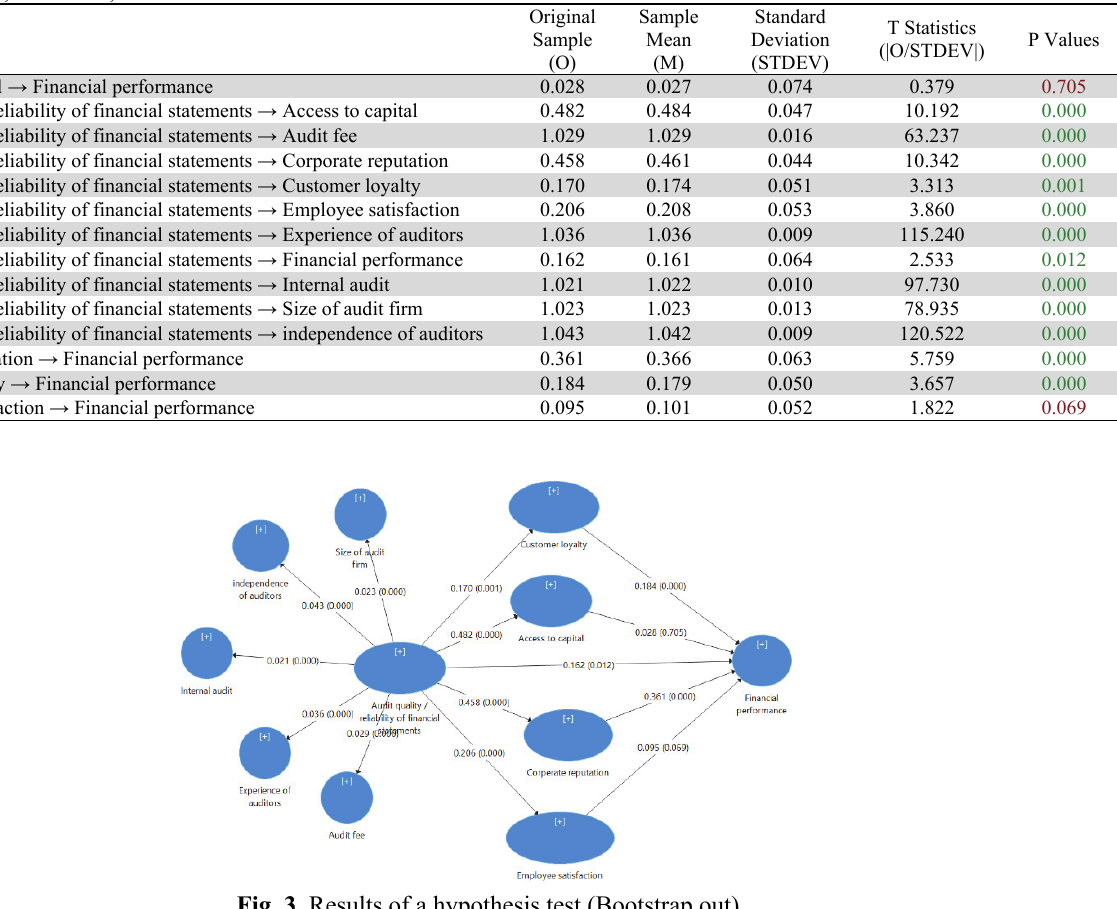
Fig. 3. Results of a hypothesis test (Bootstrap